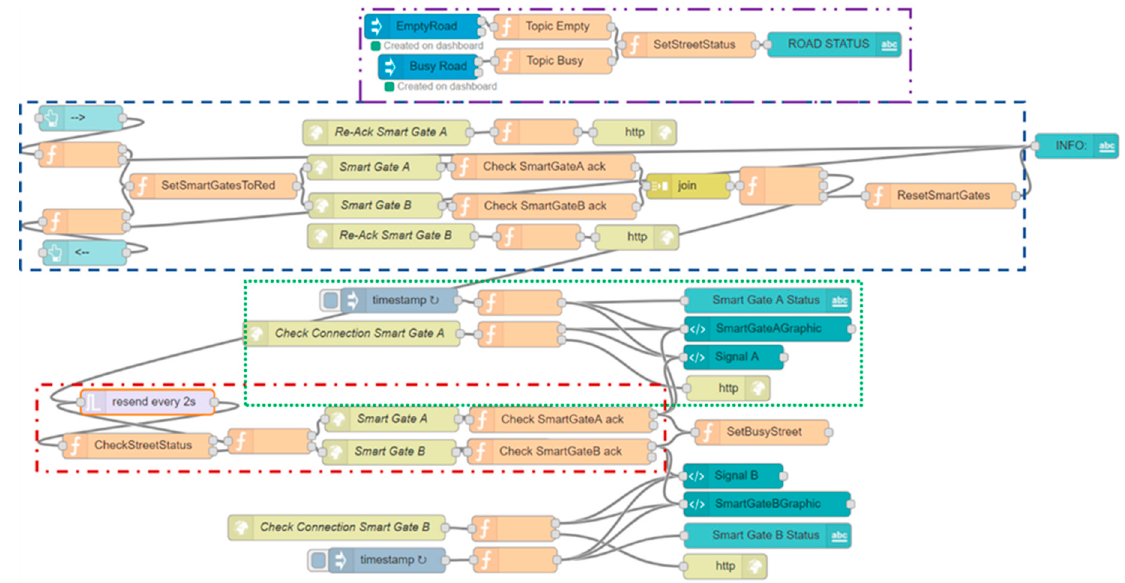
Figure 8. Complete flow of Node-RED that allows to realize the “Smart Gate Change” protocol.